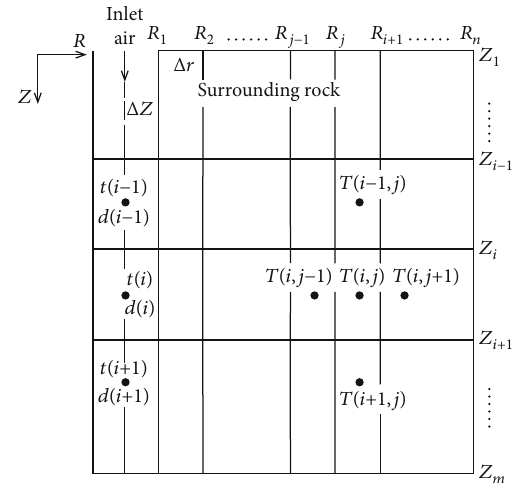
Figure 2: Finite di ff erence